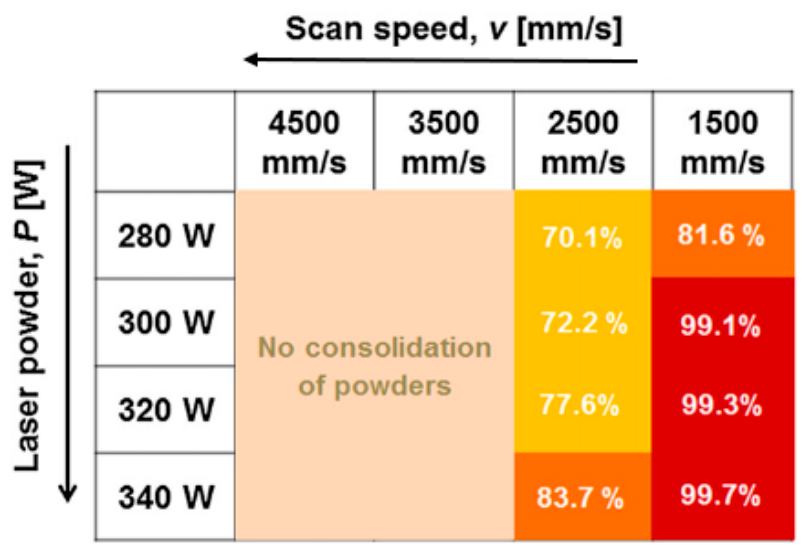
Figure 5. Relative density map of the selective laser melting (SLM)-processed Fe 68.3 C 6.9 Si 2.5 B 6.7 P 8.7 Cr 2.3 Mo 2.5 Al 2.1 specimens as a function of laser power and scan speed, the values of which increase in the directions of the arrows. Figure taken from and reprinted with the permission from [8], Elsevier, 2015 (Common Grading Scale (CGS) to The International System of Units (SI) conversion 1 emu/g = 1 Am 2 /kg and 1 Oe = 79.6 A/m).